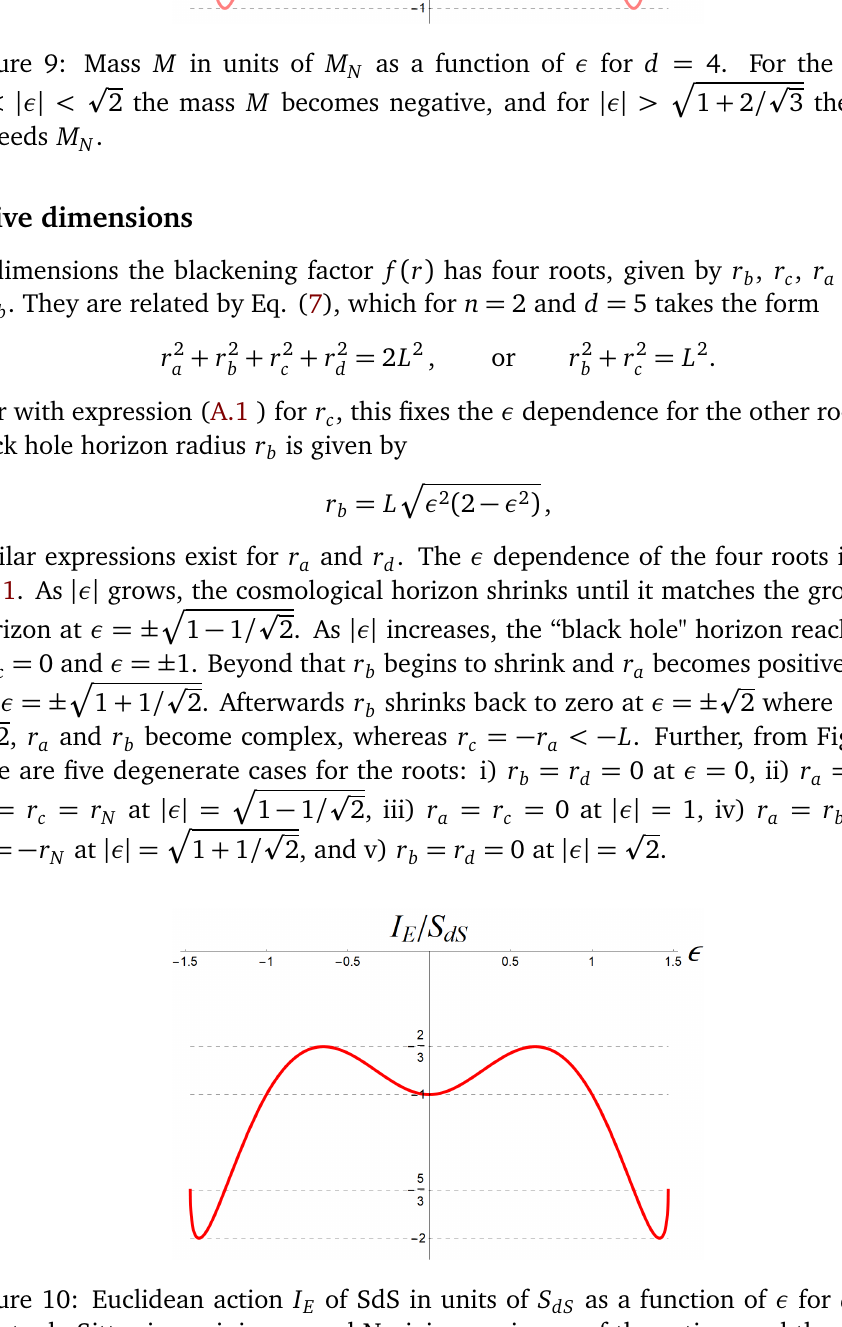
as a function of ε for d = 4. For the values N